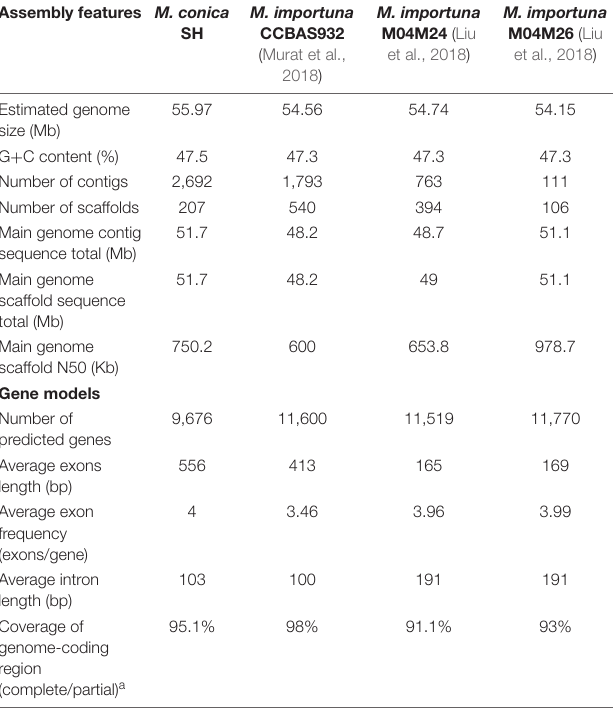
TABLE 1 | Statistics of the genome assembly of Morchella . Assembly features M. conica